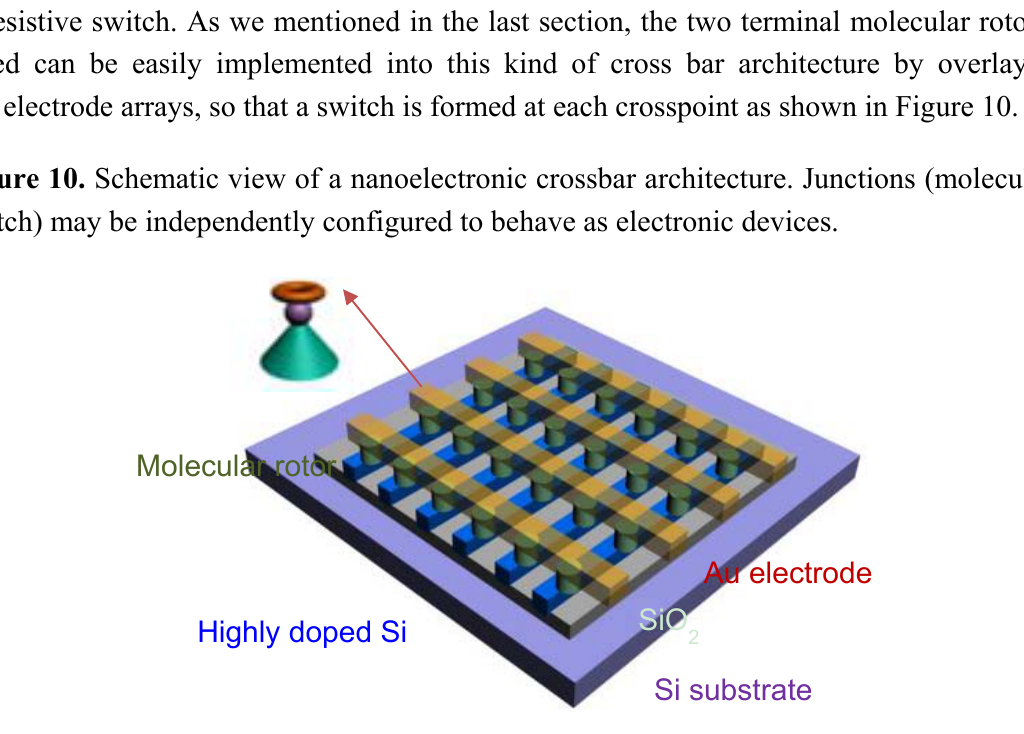
Highly doped Si